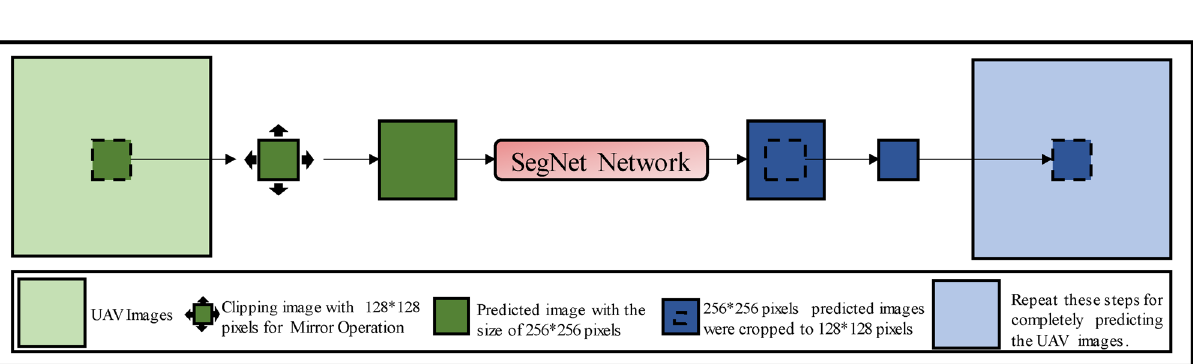
Figure 4. Processing of optimizing image algorithm for post-processing of SegNet model